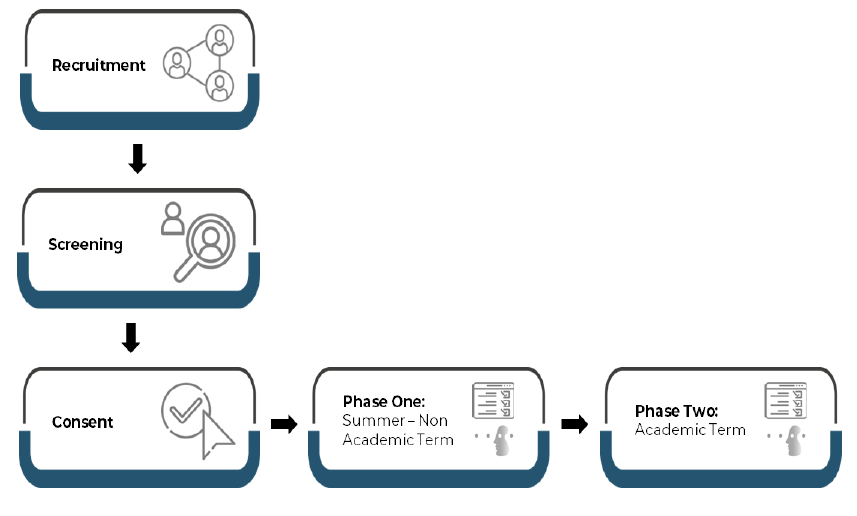
Figure 1. Study Design.